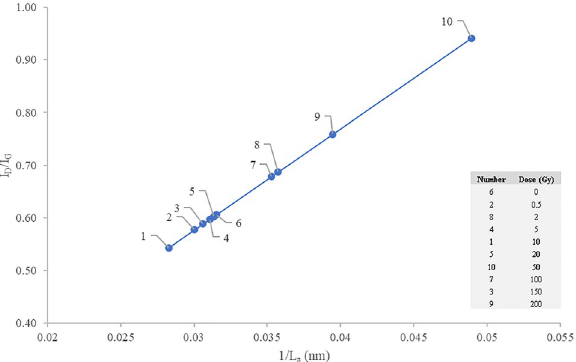
60 Co γ -ray doses from 0 to 200 Gy. The